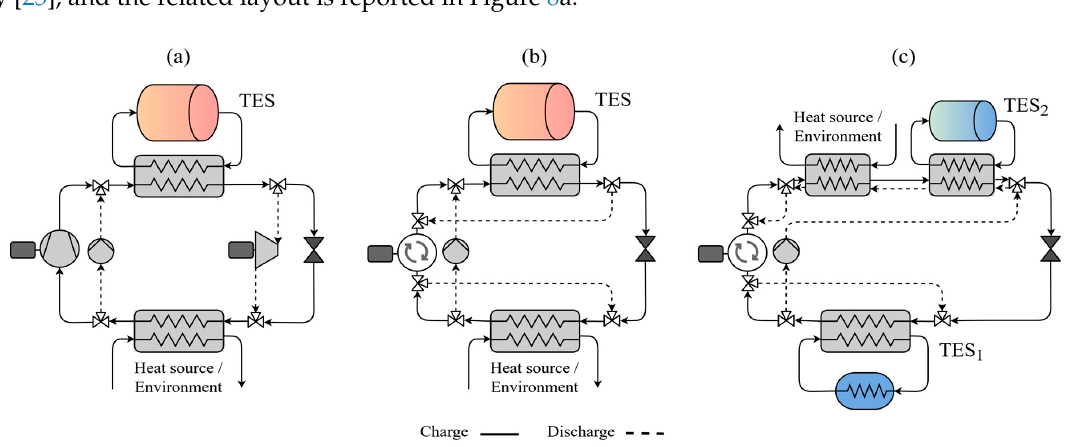
Figure 8. Partly and fully reversible TI-PTES configurations proposed in the literature. ( a ) Partly reversible “hot TI-PTES” proposed in [25]. ( b ) Fully reversible “hot TI-PTES” proposed in [26,47]. ( c ) Fully reversible “cold TI-PTES” proposed in